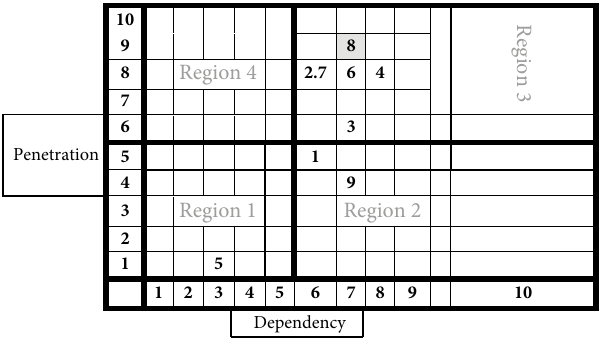
Figure 1. Penetration power and dependency degree